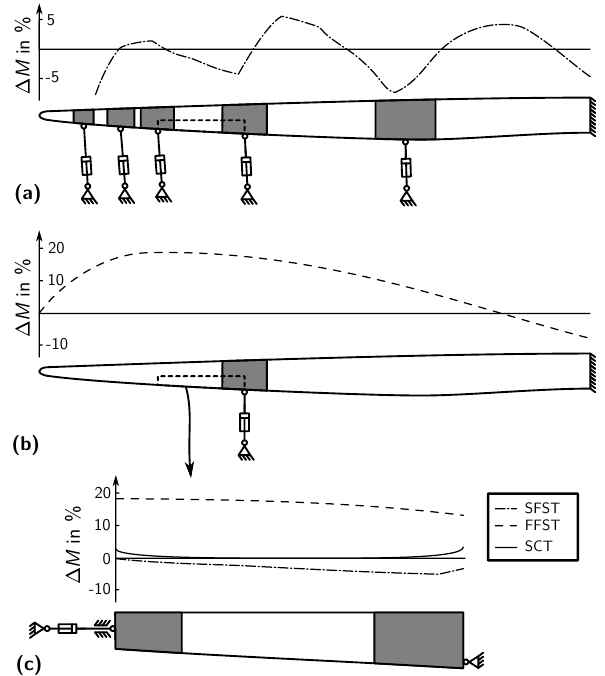
Figure 1. Load deviation (cid:49)M between test bending moment and target bending moment determined for the DTU10MW blade and test setup for static full-scale test (SFST) in side view (excerpt from Antoniou et al., 2015) (a) , fatigue full-scale test (FFST) in top view (b) and blade cutout subcomponent test (SCT) (c) . Untested areas are shown in